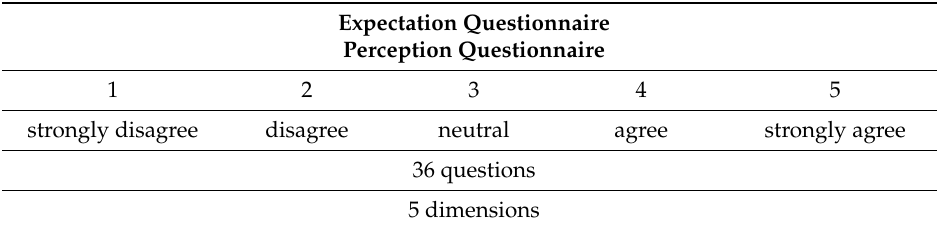
Table 4. Questionnaires